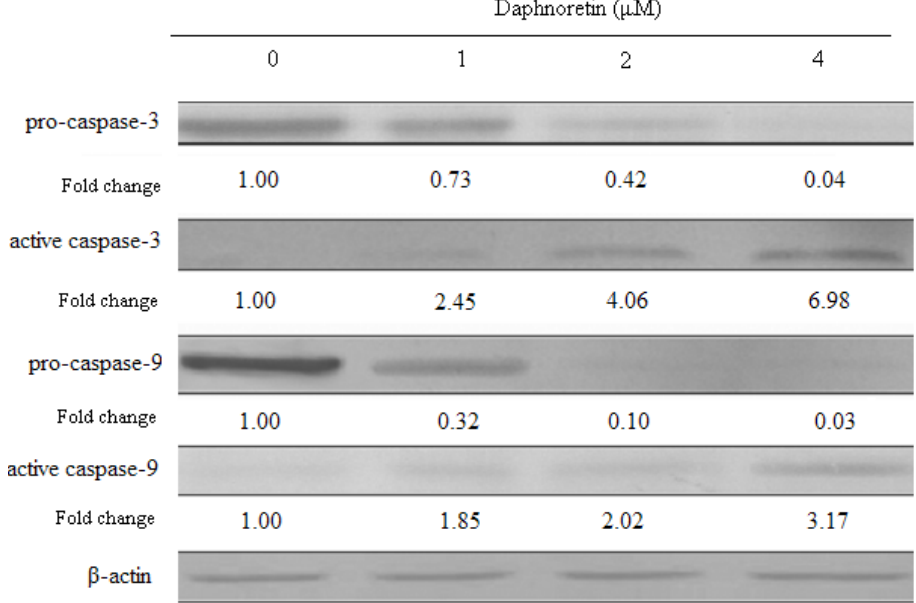
Figure 8. Changes in the expression of apoptosis-related proteins in response to treatment with daphnoretin for 48 h. The blots were stripped and reprobed with anti- β -actin antibody to normalize protein loading. Fold change was calculated as described in Figure